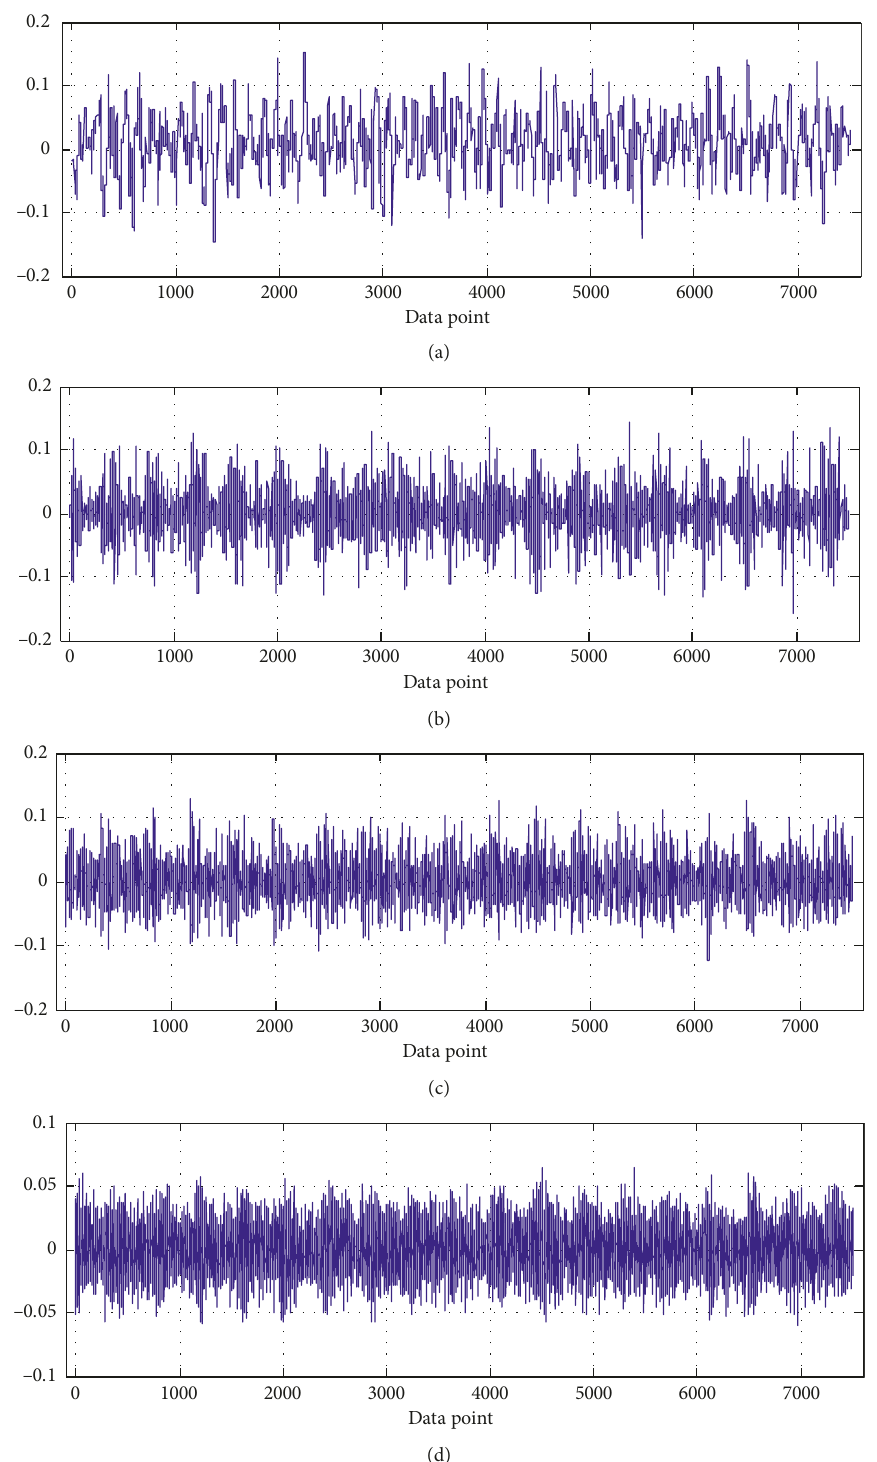
Figure 2: The four LWCs’ reconstructed signals of one of the samples representing the normal state in the training samples. (a) Reconstructed signal of lifting wavelet coefficient 1, (b) reconstructed signal of lifting wavelet coefficient 2, (c) reconstructed signal of lifting wavelet coefficient 3, and (d) reconstructed signal of lifting wavelet coefficient